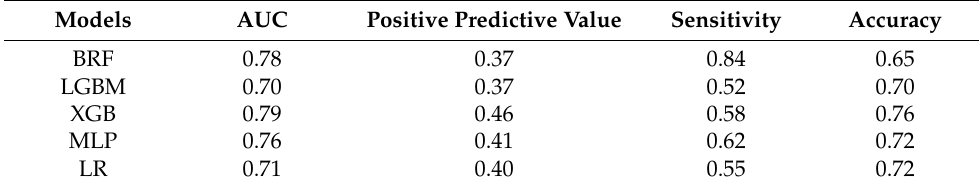
Figure 1. Receiver operating characteristic (ROC) curves for predicting 30-day mortality in mechani- cally ventilated patients: ( a ) in the internal validation, machine learning models showed AUCs from 0.75 to 0.80. ( b ) In the external validation, AUCs of XGB, BRF, MLP, LR, and LGBM were 0.79, 0.78, 0.76, 0.71, and 0.70, respectively. AUC, area under the receiver operating characteristic curve; BRF, balanced random forest; LGBM, light gradient boosting machine; XGB, extreme gradient boosting; MLP, multilayer perceptron; and LR, logistic regression. Table 2. Performance metrics of 30-day mortality prediction models in the external validation set.